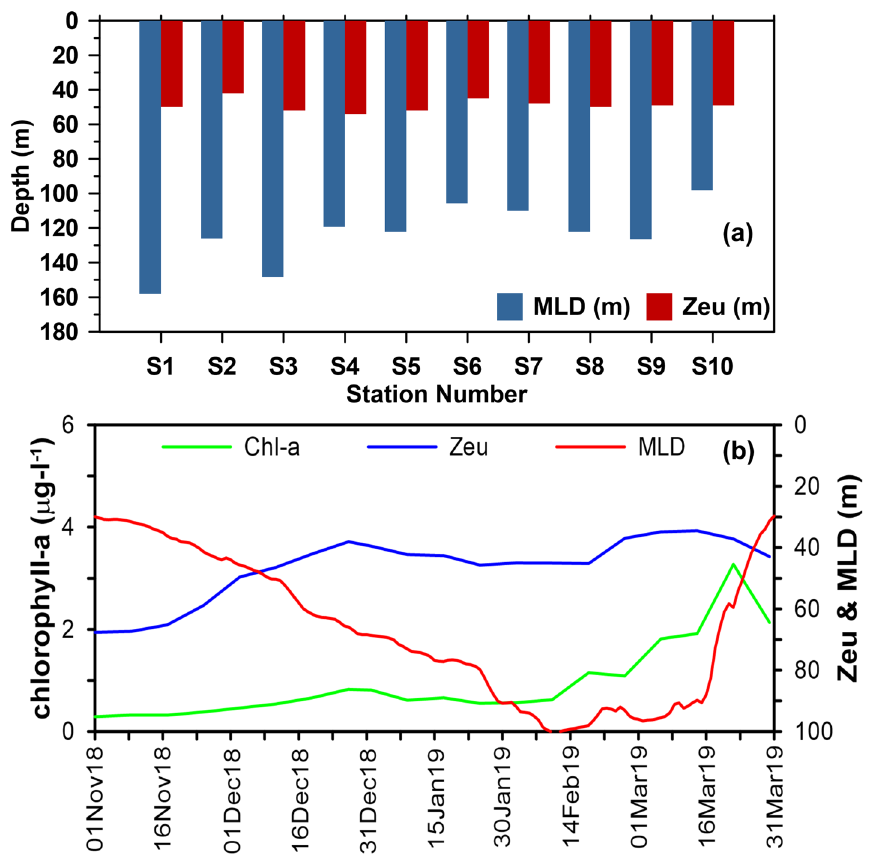
Figure 4. (a) Bar diagram of euphotic depth (red) and mixed layer depth (blue) at 10 sampling stations, (b) time-series of simulated mixed layer depth (INCOIS- GODAS), satellite derived euphotic depth and surface chl- a